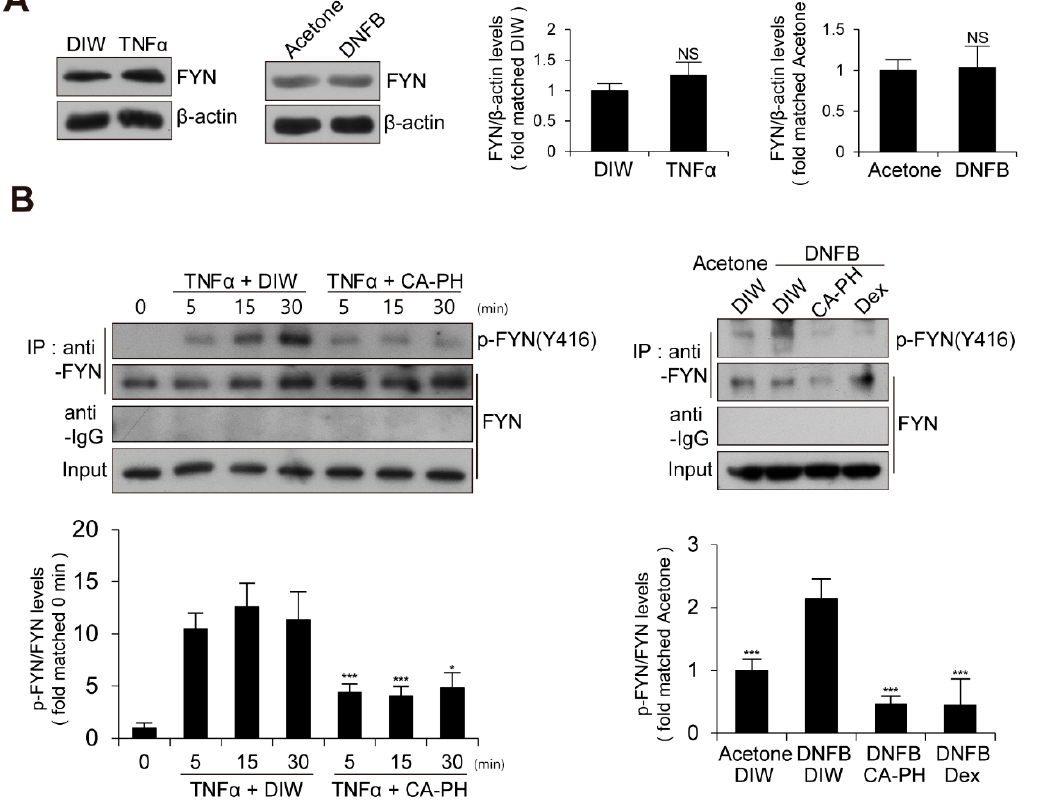
Figure 4. Activation of Fyn in TNF α -treated keratinocytes and DNFB-induced AD-like mouse skin. ( A ) Expression levels of Fyn are not changed in TNF α -treated HaCaT keratinocytes or DNFB-treated mouse skin. DIW and acetone were used as solvents for TNF α and DNFB, respectively. Western blot analysis was performed using anti-Fyn antibody. As a loading control, anti- β actin antibody was used. Representative images are shown. Data were quantitatively assessed and additionally depicted in graphs ( n = 3). ( B ) Increased kinase activity of Fyn in TNF α -treated HaCaT keratinocytes or DNFB-treated mouse skin. Fyn was immunoprecipitated with anti-Fyn antibody and immunoblotted with anti-phospho SRC (Y416) antibody. Data were quantitatively assessed and are additionally depicted in graphs ( n = 3). All data represent mean ± S.E.M. Significance values were * p ≤ 0.05, and *** p ≤ 0.005. Dex, dexamethasone; DIW, deionized water; TNF α , tumor necrosis factor alpha; NS, no significance.